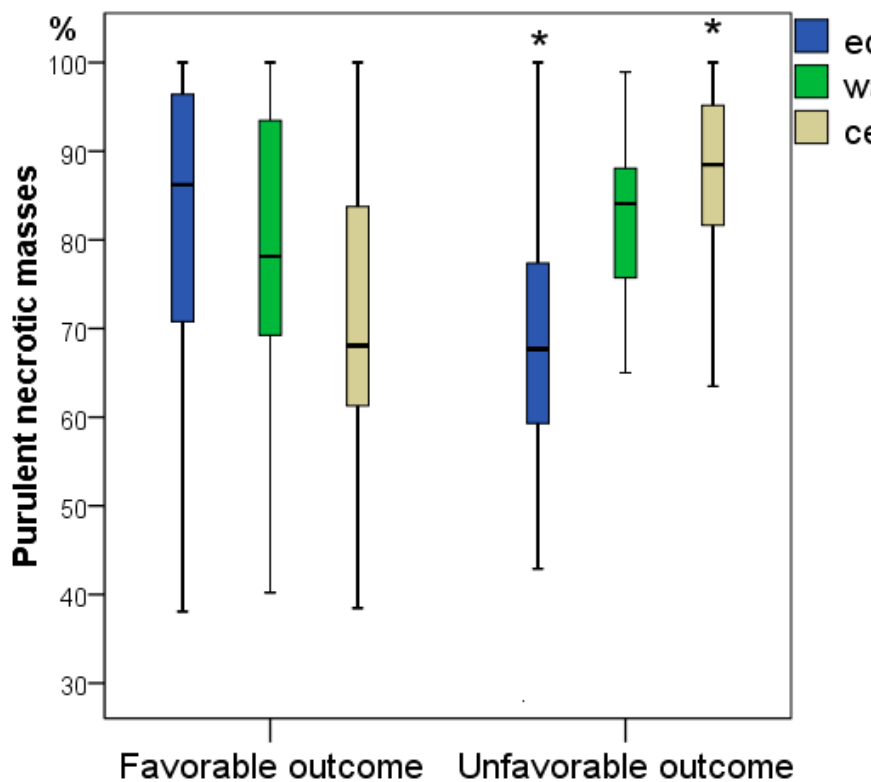
Figure 3. Frequency of representation of leukocyte-necrotic tissues in different parts of wounds obtained during the primary surgical treatment for patients with a favourable and unfavourable outcomes of diabetic foot treatment (*—difference between groups in terms of outcome at p < 0.05; Mann–Whitney U test).